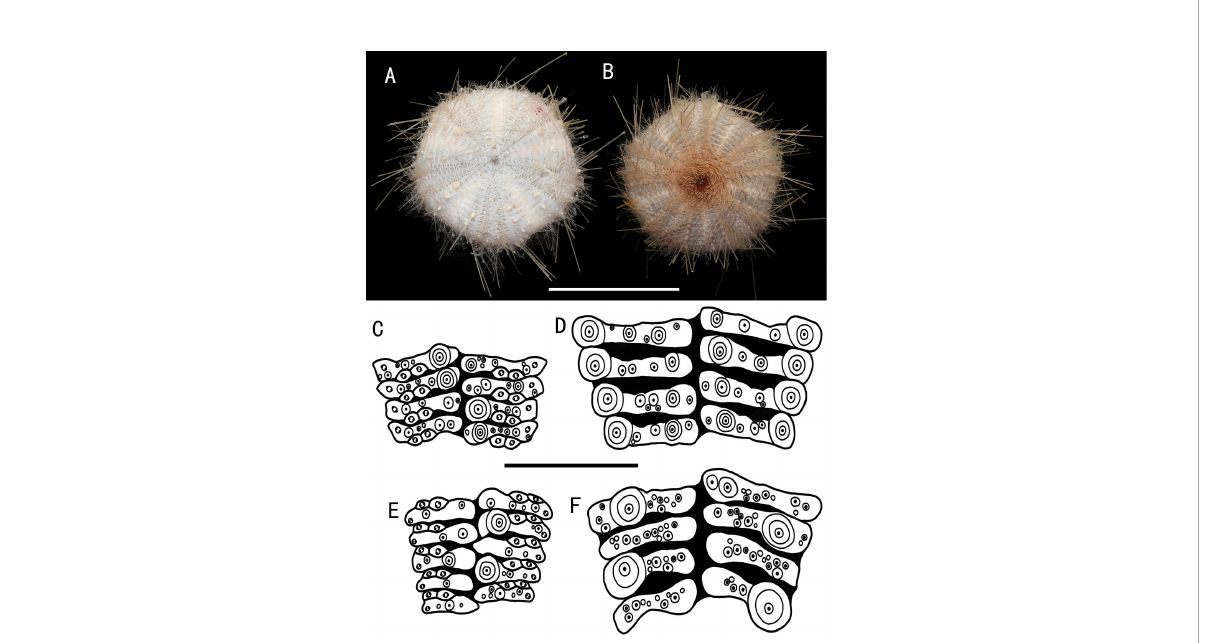
FIGURE 11 Araeosoma bidentatum , MBM286957 (test diameter, 61.5 mm). (A) Aboral view. (B) Oral view. (C – F) Details of the coronal plates: (C) , oral ambulacra (D) , oral interambulacral (E) , aboral ambulacra (F) aboral ambulacra. Scale bars , 50 mm (A, B) and 10 mm (C – F)